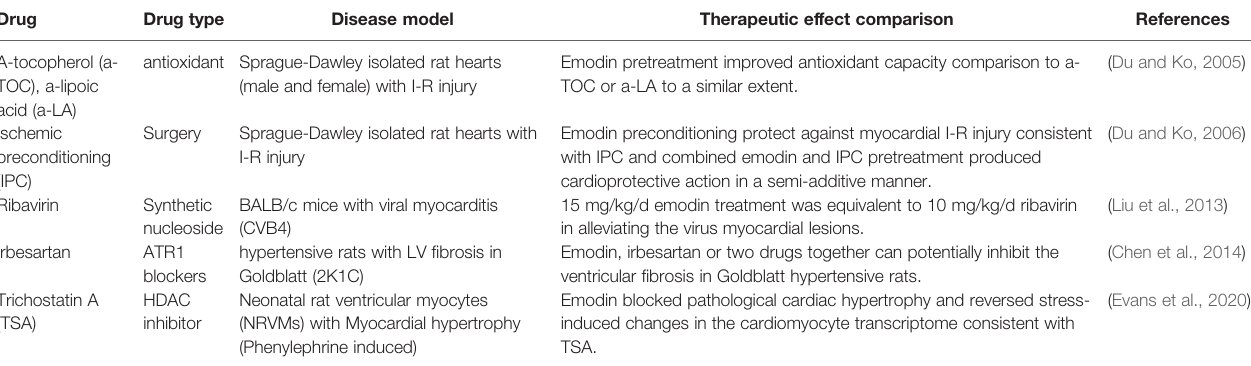
TABLE 2 | Emodin and conventional therapeutic methods against cardiovascular